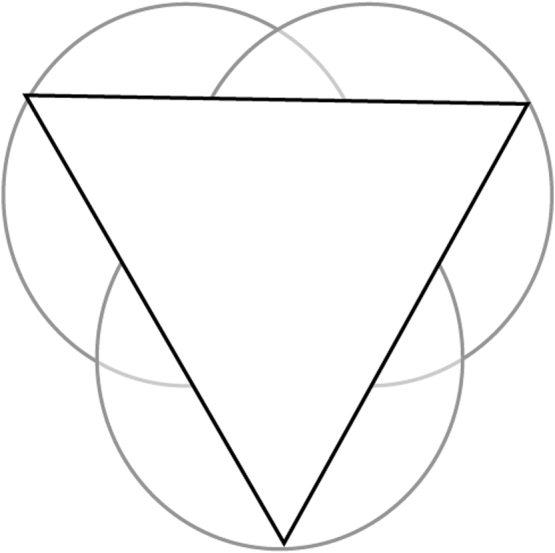
Overlay triangle.